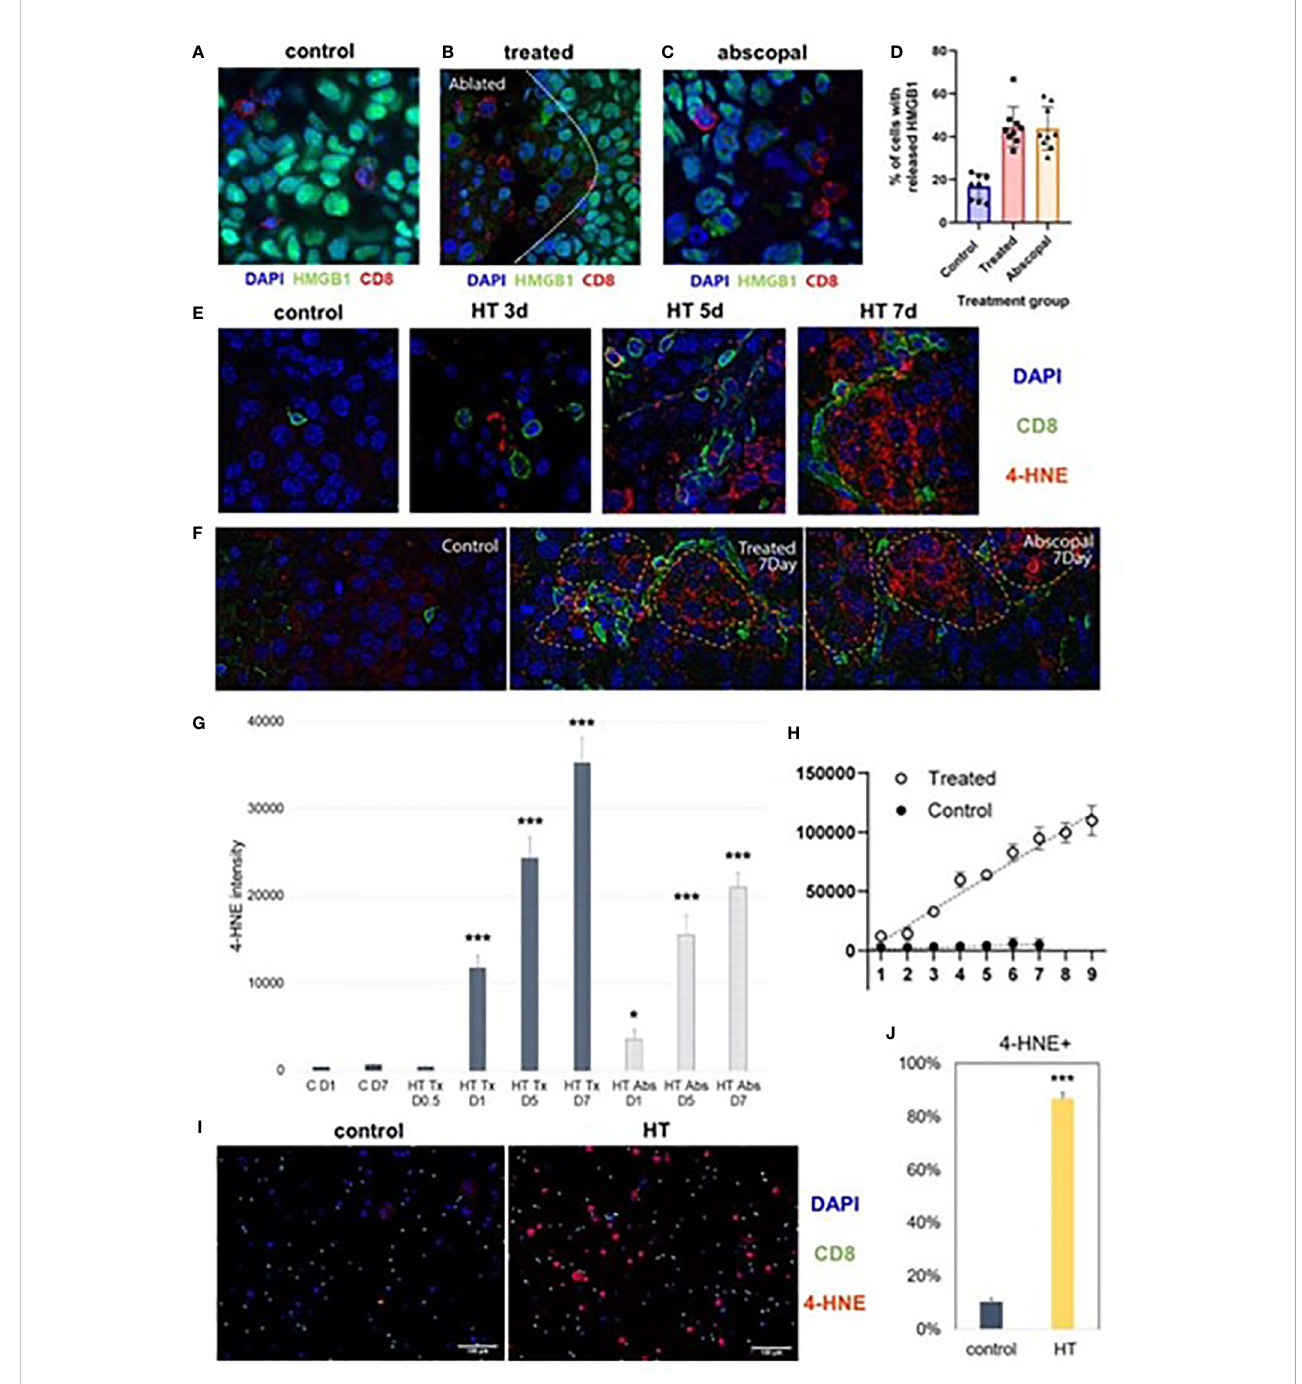
FIGURE 5 Late intratumoral CD8+ cell in fi ltration co-localizes with immunogenic and ferroptotic cancer cell death following histotripsy. Mice bearing bilateral B16F10 tumors were treated with unilateral sham (control) or partial histotripsy ablation on day 10. (A) Multicolor immuno fl uorescence performed on day 7 after sham or histotripsy ablation revealed minimal CD8+ cell in fi ltration and minimal extranuclear translocation of HMGB1 among cancer cells in control tumors. CD8+ cell in fi ltration was co-localized with loss of intranuclear HMGB1 staining in histotripsy-treated tumors (B) and in histotripsy- abscopal tumors (C) . (D) Signi fi cantly higher percentages of cancer cells located within 50 m m of a CD8+ cell exhibited loss of nuclear HMGB1 in histotripsy-treated and histotripsy-abscopal tumors as compared with controls. (E) Multicolor immuno fl uorescence performed on days 3, 5 and 7 after sham or histotripsy ablation revealed spatial co-localization of CD8+ cell in fi ltration with cancer cell accumulation of 4-HNE, a byproduct of ferroptosis, in histotripsy-treated tumors but not in control tumors. (F) Strong co-localization was observed between CD8+ cell in fi ltration and 4-HNE on day 7 in histotripsy-treated and histotripsy-abscopal tumors, but not in control tumors. (G) Gradual accumulation of 4-HNE staining intensity was observed in histotripsy-treated ( “ HT Tx ” ) and histotripsy-abscopal ( “ HT Abs ” ) tumor cells. (H) A linear relationship was observed between number of CD8+ cells present (x axis) and intensity of 4-HNE expression within 50 m m (y-axis) in histotripsy-treated tumors but not in control tumors. (I, J) Mice bearing B16F10 fl ank tumors were treated with sham or histotripsy tumor ablation on day 10, and tumor-draining lymph nodes were harvested on day 15. CD8+ T cells derived from tumor-draining lymph nodes were co-cultured with B16F10 melanoma cells in vitro . Signi fi cant accumulation of 4-HNE was observed within B16F10 melanoma cells co-cultured with CD8+ T cells derived from lymph nodes draining histotripsy-treated but not sham-treated tumors. (n=3-6 mice per group; *=p < 0.05 compared with control day 1 tumors; ***=p < 0.001 compared with control day 1